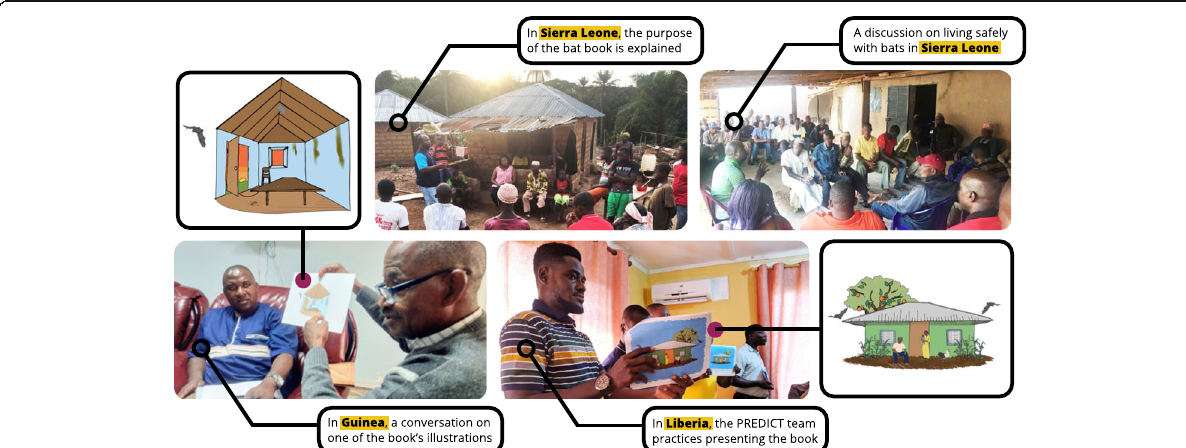
Fig. 6 Implementation of the Living Safely with Bats resource in West Africa, which provided scripted talking points for moderators. These talking points covered themes such as basic ways to live safely with bats, disposal of dead bats, what to do with them when contact is unavoidable, and managing bats living in and around the